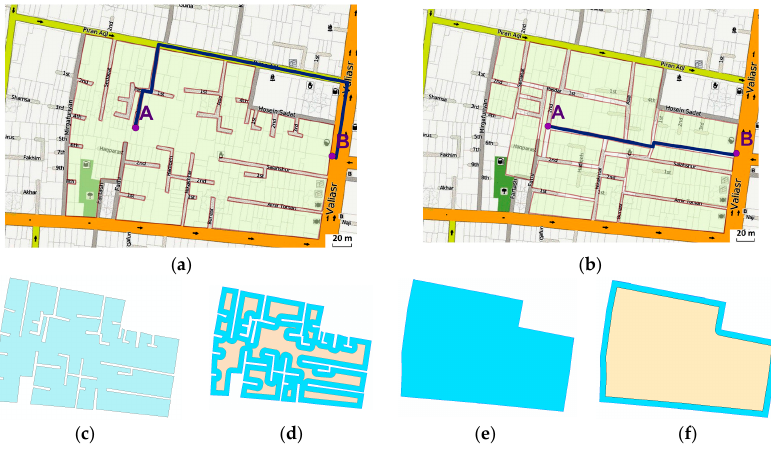
Figure 4. ( a ) Paths between two points a and b for ( a ) a hierarchical layout; ( b ) non-hierarchical layout; ( c ) a block in a hierarchical layout; ( d ) core areas of the same block; ( e ) same block when its notches are removed and has straight edges; and ( f ) the NCA of the block is reduced to one when all notches are removed. Table 7. Parameters and rules that qualify the city permeability.